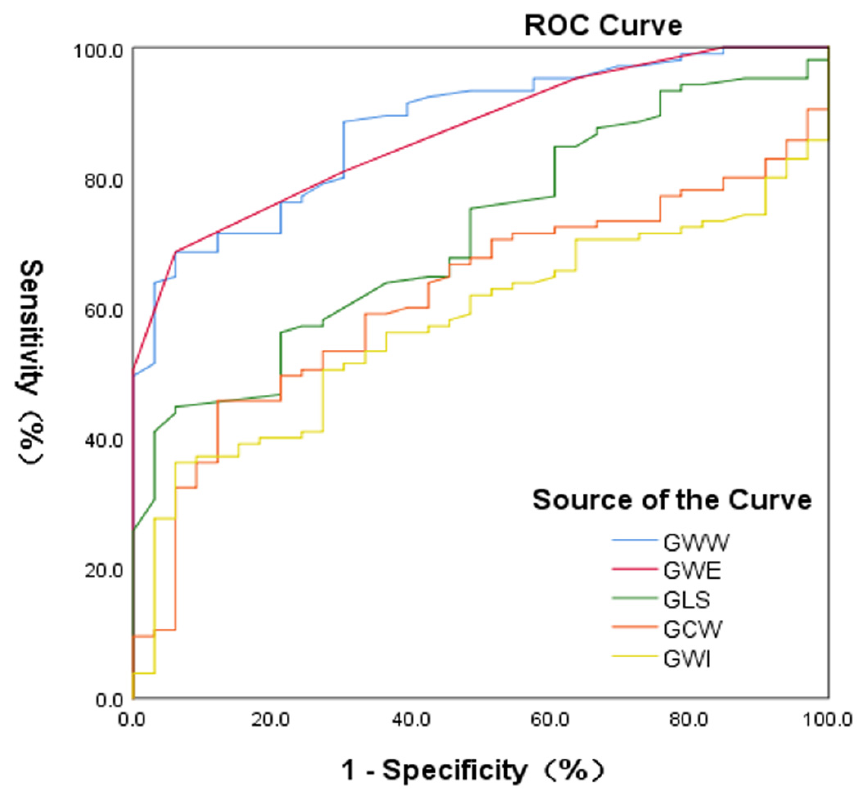
Figure 3. Receiver-operating characteristic (ROC) curve analyses for the accuracy of GWI, GCW, GWW, GWE, and GLS parameters to identify chronic kidney disease patients with myocardial injury. The analyses include all study participants (N = 138). GLS, global longitudinal strain; GWI, global work index; GCW, global constructive work; GWW, global waste work; GWE, global work efficiency.